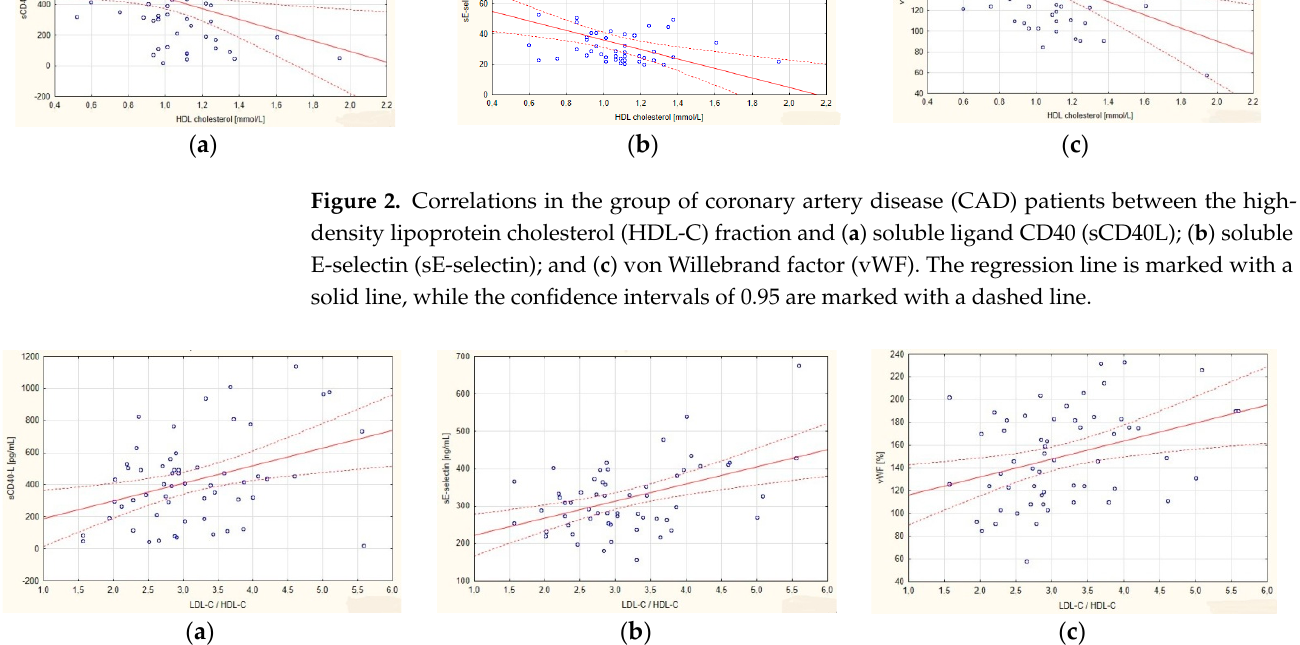
Figure 3. Correlations in the group of patients with coronary artery disease (CAD) between the atherogenic indicator, LDL-C/HDL-C, and ( a ) soluble ligand CD40 (sCD40L); ( b ) soluble E-selectin (sE-selectin); and ( c ) von Willebrand factor (vWF). The regression line is marked with a solid line, while the confidence intervals of 0.95 are marked with a dashed line.